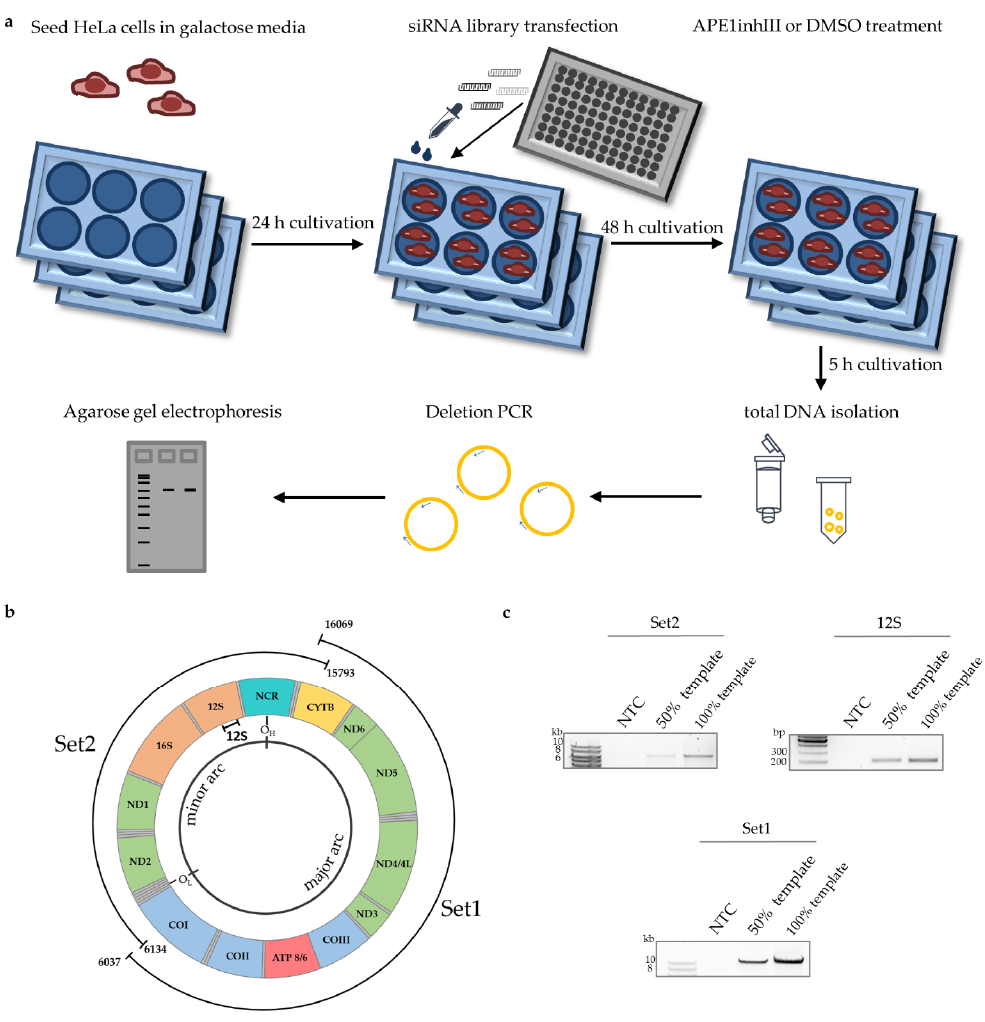
Figure 1. Screening for proteins involved in mtDNA maintenance. Schematic representation of experimental design for siRNA screening of a library comprising 57 siRNAs and nsRNA control ( a ), scheme of mitochondrial long-range PCR for amplification of whole mitochondrial genome; NCR is for the non-coding (regulatory) region ( b ) and representative agarose gels of amplified mitochondrial regions (Set1, Set2, 12S) confirming analysis in the linear range of PCR (no template control (NTC), 50% template, and 100% template) ( c ).